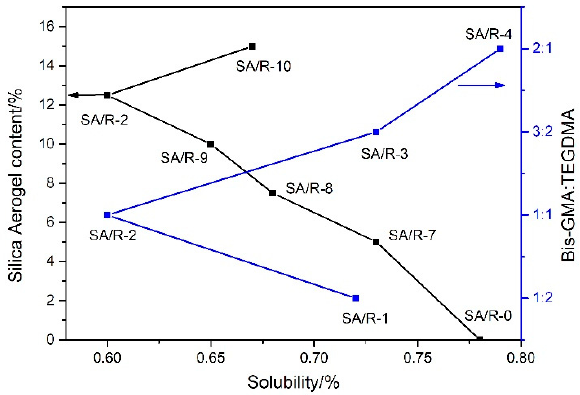
Figure 10. Solubility (SL) of silica aerogel/resin